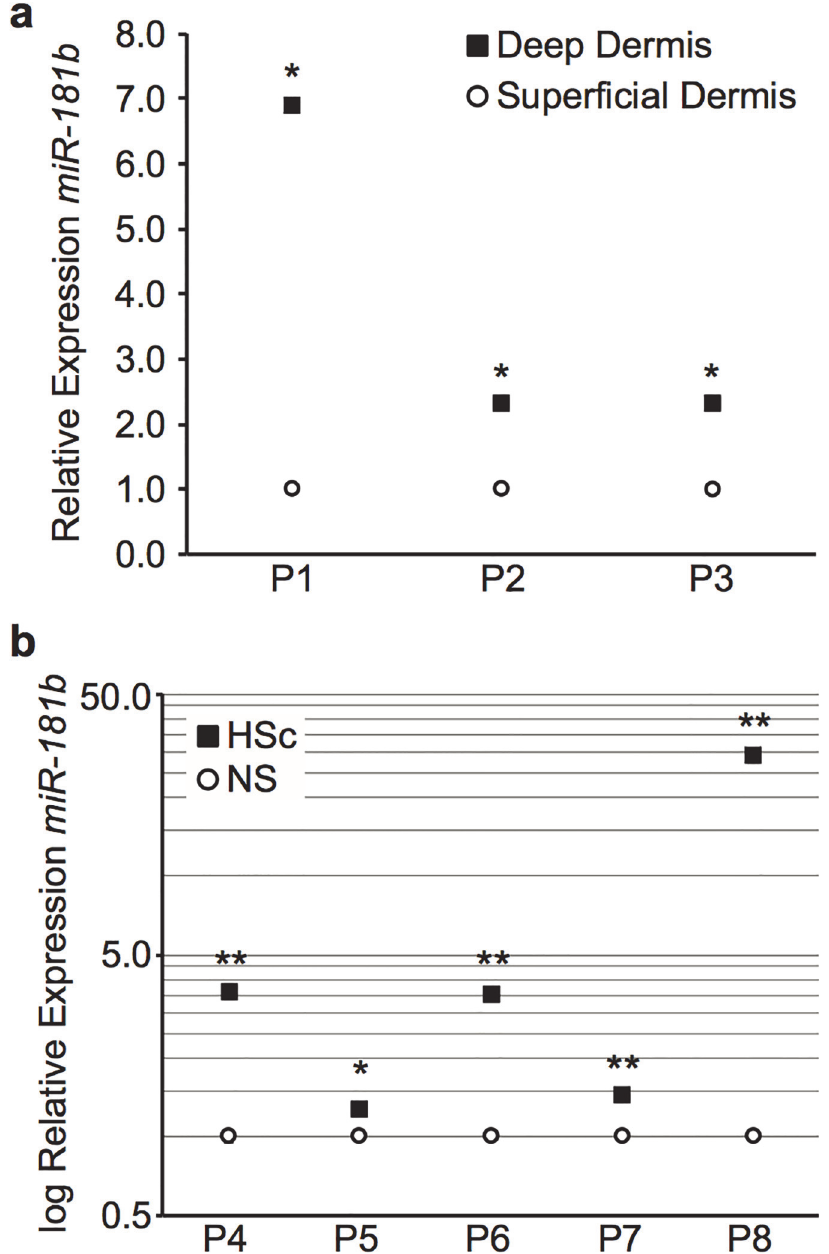
Fig 4. Relative expression of miR-181b in matched superficial and deep dermis and site-matched NS and HSc biopsies. Total RNA was extracted from tissue specimens using a chilled pestle and mortar and Trizol for relative quantitation using RT-qPCR. (a) Relative expression of miR-181b in matched superficial and deep dermis of NS (mean ± SEM, n = 3 samples per patient, * P < 0.001). (b) Relative expression of miR-181b in matched NS and HSc (mean ± SEM, n = 3 samples per patient, * P < 0.05, ** P <